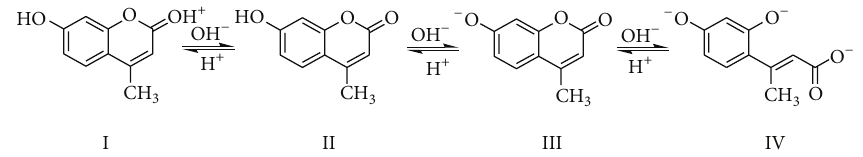
Figure 3: Proton ionization and hydrolysis process of 4MU.